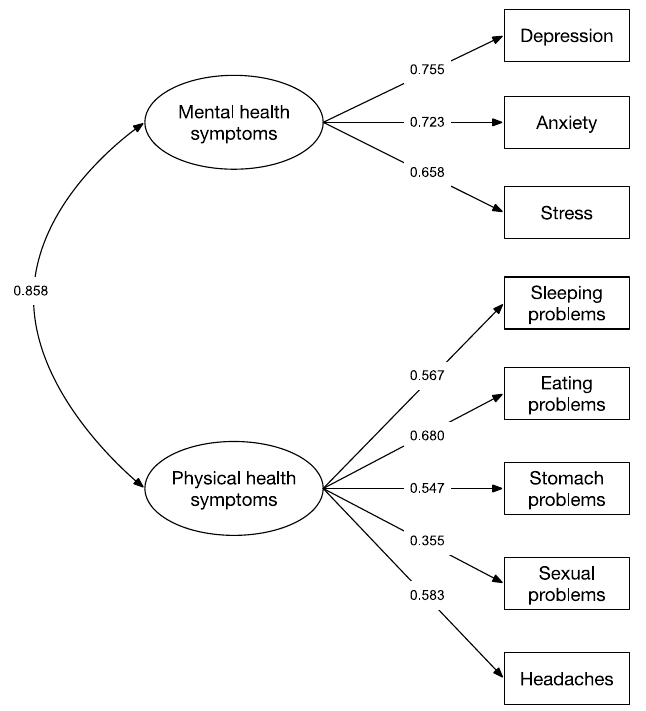
Figure 1. Confirmatory model of the scale of mental and physical health symptoms in the sample of emerging adulthood ( n = 647).